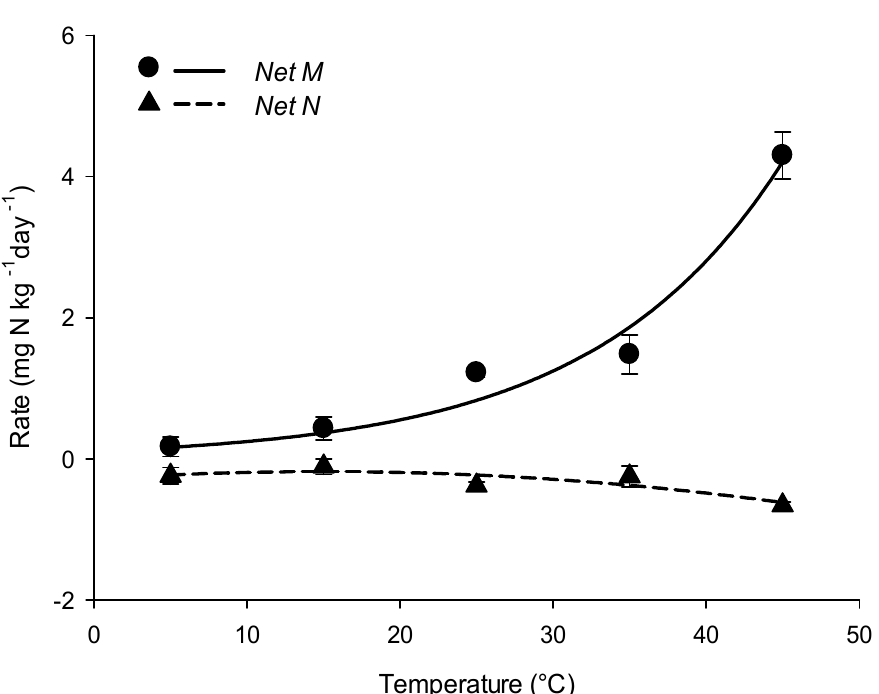
Figure 2. The non-linear trends in net rates of N mineralization ( Net M ) and nitrification ( Net N ) as function of imposed incubation temperatures. Vertical bars indicate standard deviations of the mean value.